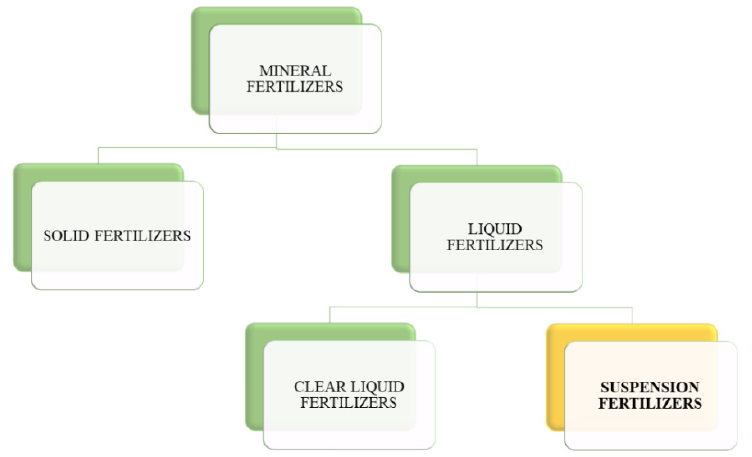
Figure 1. Classification of fertilizers according to their physical form. Due to their physical form, mineral fertilizers can be divided into solid fertilizers and liquid fertilizers. Suspension fertilizers belong in the group of liquid fertilizers.